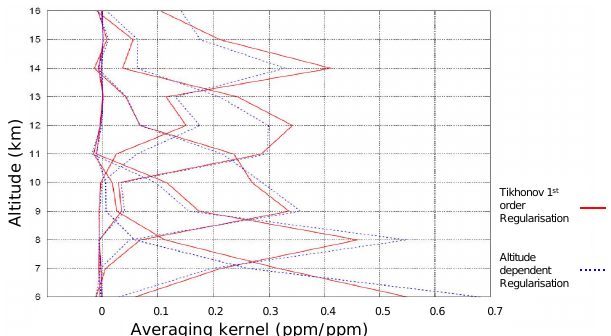
Fig. 4b. Averaging kernels for levels at 6, 8, 10, 12, and 14km for one occultation. The red curve corresponds to a first order Tikhonov regularisation and the blue curve to an altitude dependent regulari- sation based on a Tikhonov first order